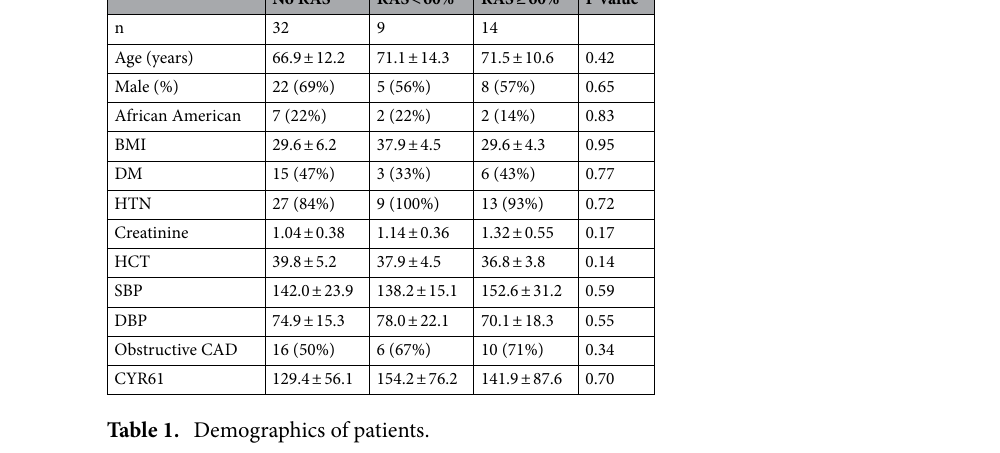
Table 1. Demographics of